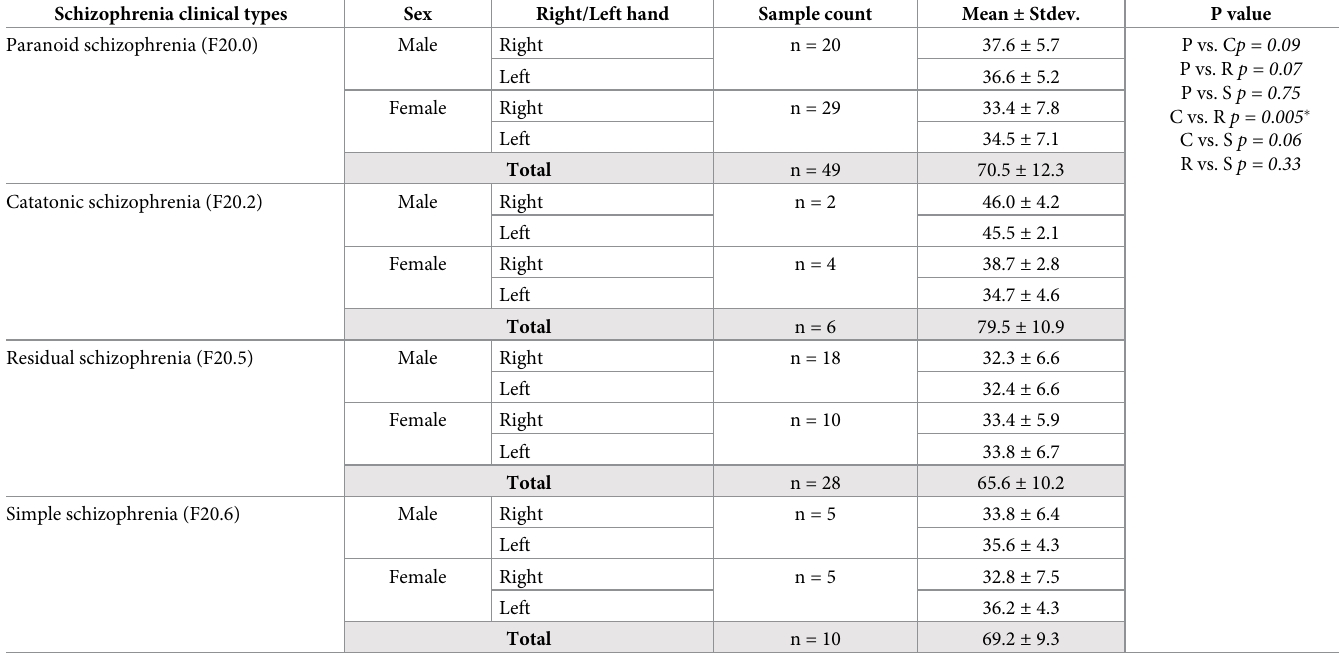
Table 7. Mean of A-B ridge count by schizophrenia clinical types.